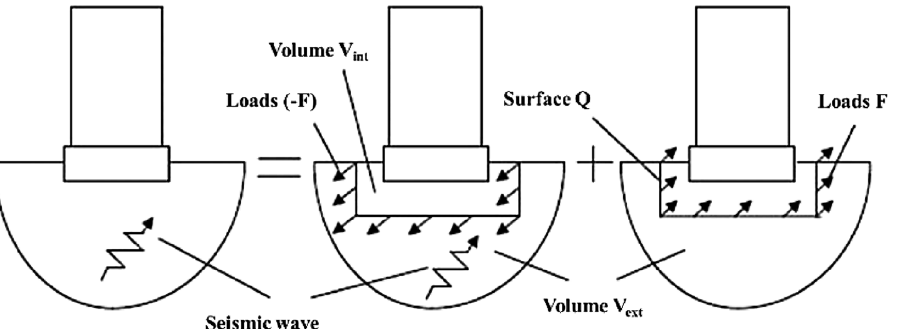
Figure 2. Substructure method for SSI analysis.